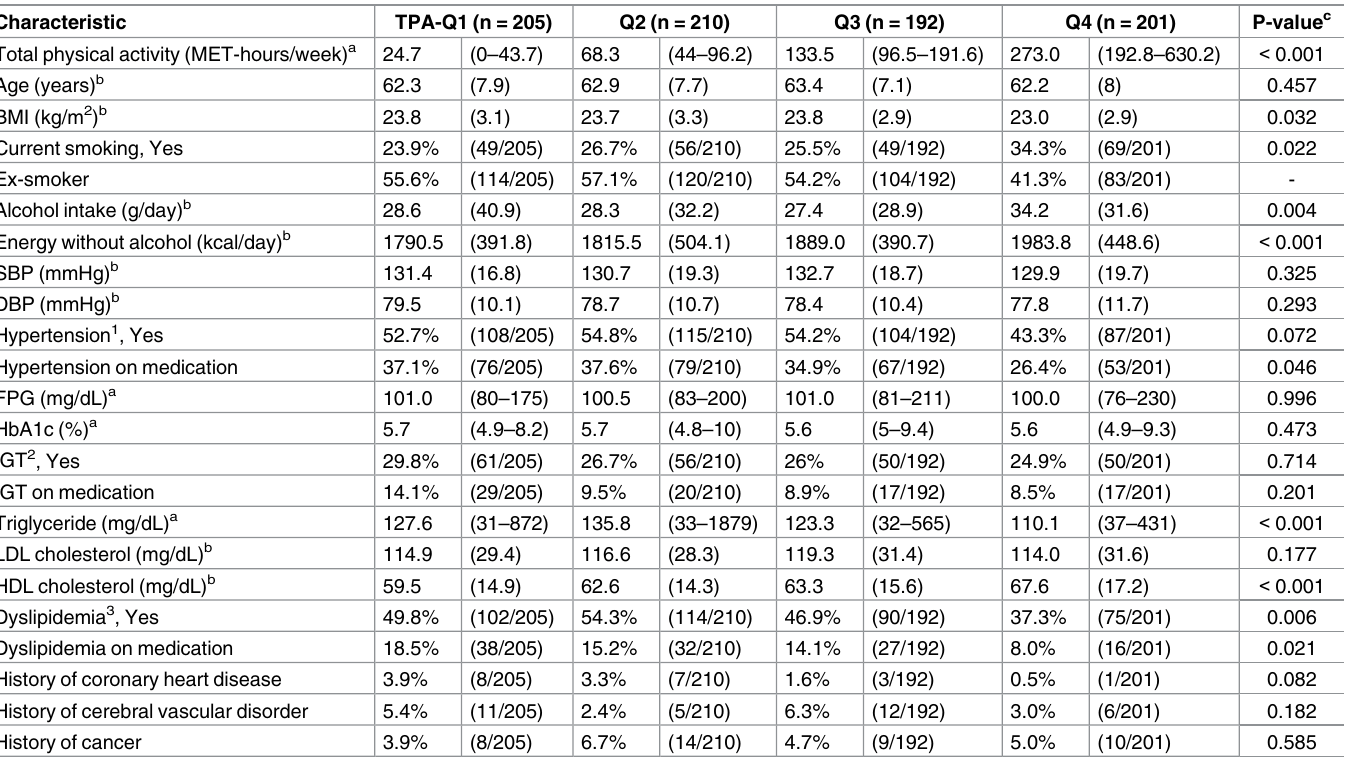
Table 1. Characteristics of the original population (n =